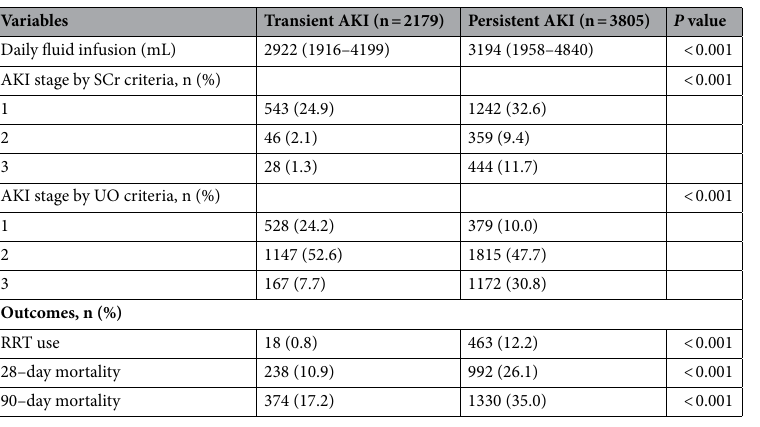
Table 1. Baseline characteristics and outcomes of patients stratified by the persistence of AKI. AKI, acute kidney injury; ICU, intensive care unit; MICU, medical intensive care unit; SICU, surgical intensive care unit; TSICU, trauma surgical intensive care unit; CCU, coronary care unit; CSRU, cardiac surgery recovery unit; AIDS, acquired immune deficiency syndrome; MAP, mean arterial pressure; WBC, white blood cell; PaO 2 , partial pressure of oxygen; PaCO 2 , partial pressure of carbon dioxide; INR, international normalized ratio; PTT, partial thromboplastin time; RRT, renal replacement therapy; SCr, serum creatinine; UO, urine output. Continuous variables were presented as median (interquartile range) and categorical variables were presented as n (%).